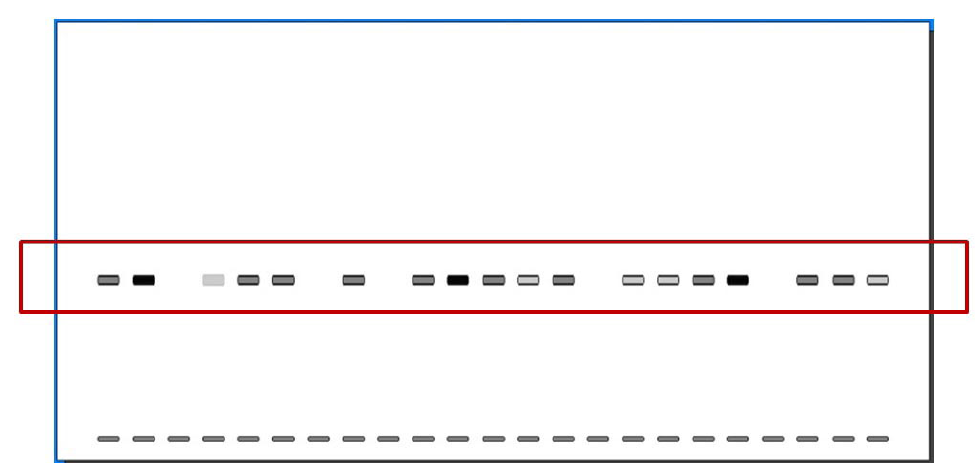
Figure 5. Potential for fast quantitation by automated horizontal scanning HPTLC-DART-MS along the substance window for a zone of interest on a TLC/HPTLC